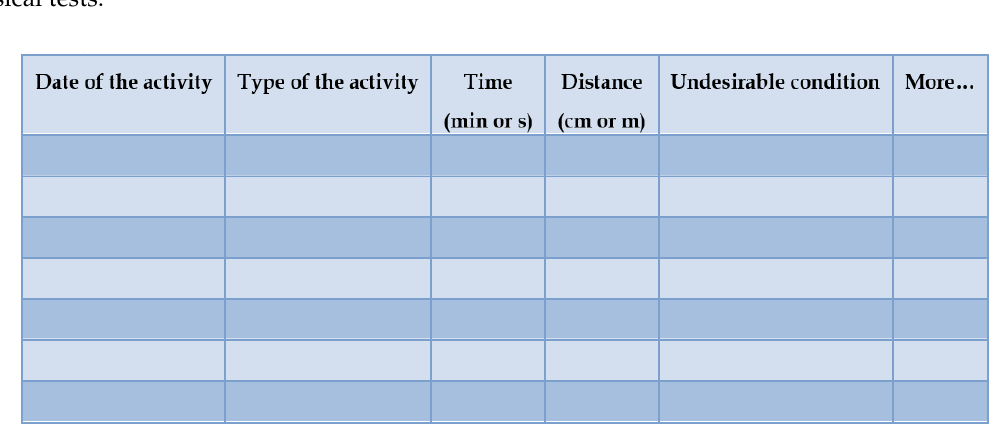
Figure 1. Spreadsheet suggestion to allow the individual to register the daily “self-progress” of the home-based exercises adapted from the physical tests.